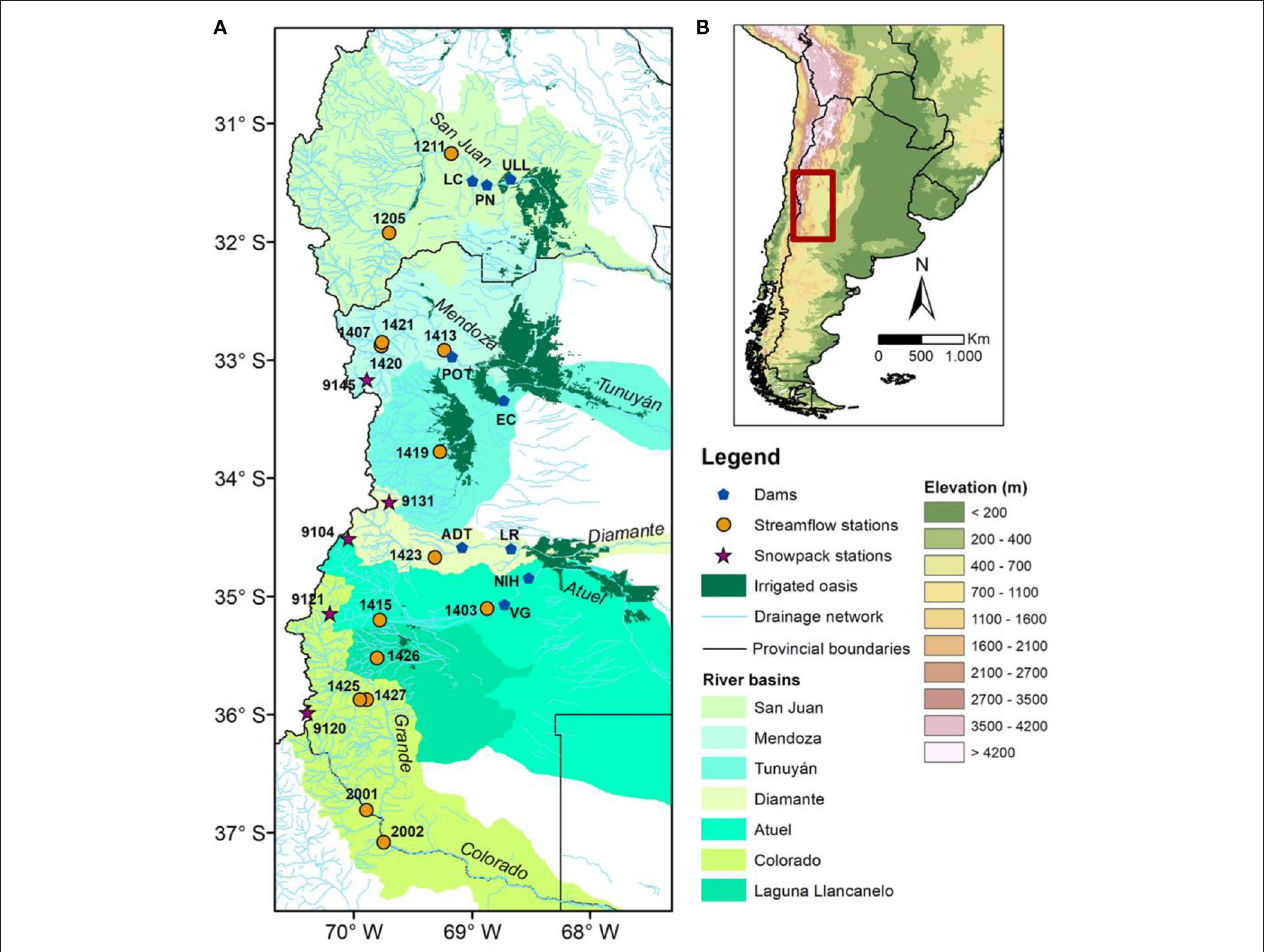
FIGURE 1 | (A) Study area with the location of the main river basins, the natural drainage network, the irrigated oases, the streamflow and snowpack stations, and the main dams. The names of the dams are the following: PN, Punta Negra; ULL, Ullúm; LC, Los Caracoles; POT, Potrerillos; EC, El Carrizal; ADT, Agua del Toro; LR, Los Reyunos; VG, Valle Grande; NIH, Nihuil. Details of the capacity of each dam can be found in Table 2 . (B) Regional setting of Central-Western Argentina, with the main orographic